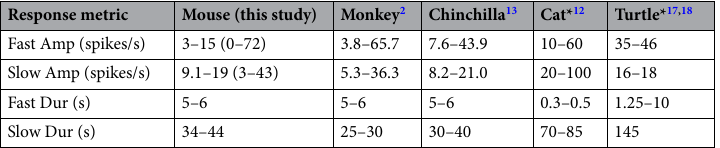
Table 1. Comparison of response metrics for efferent-mediated fast and slow excitation among different vertebrates. The range of mean response amplitudes (Amp) and durations (Dur) are provided for several mammalian species and turtle. Efferent-mediated response metrics from regular and irregular afferents have been pooled to generate the range except for cat and turtle where data were only available for irregular afferents (*). Number in parentheses for mouse are the ranges of response amplitudes taken from individual units. Amp and Dur measurements were taken from average response histograms generated with different efferents stimuli—Mouse, squirrel monkey, and chinchilla: 1–12 shock trains (333 shocks/s for 5 s) repeated every 60–75 s; Cat: 64 shock trains with each train (200 shock/s for 400 ms) presented at 1.5 s intervals; Turtle, 10–25 shock trains (200 shocks/s for 100 ms) or a single shock train (100 shock/s for 10 s). Longer response durations in cat and turtle are attributed to the length of the efferent stimulus. References for each animal are shown